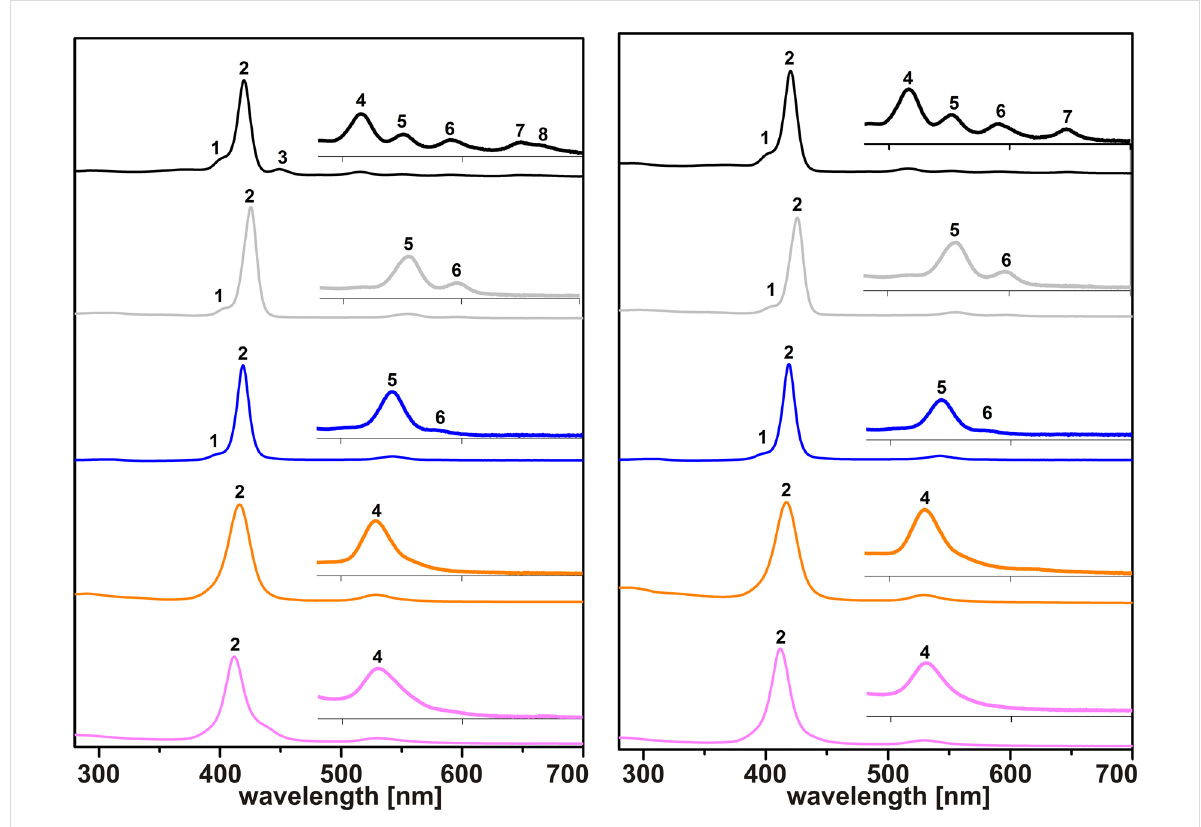
Figure 4: Left: UV–vis spectra (CHCl 3 , 280–700 nm) of H 2 TPP(C(O)NMe 2 ) 4 ( 2 ) and MTPP(C(O)NMe 2 ) 4 (M II = Zn, 2a (gray); Cu, 2b (blue); Ni, 2c (orange); Co, 2d (purple)). Right: UV–vis spectra (CHCl 3 , 280–700 nm) of H 2 TPP(C(O)N(iPr) 2 ) 4 ( 3 ) and MTPP(C(O)N(iPr) 2 ) 4 (M II = Zn, 3a (gray); Cu, 3b (blue); Ni, 3c (orange); Co, 3d (purple)).